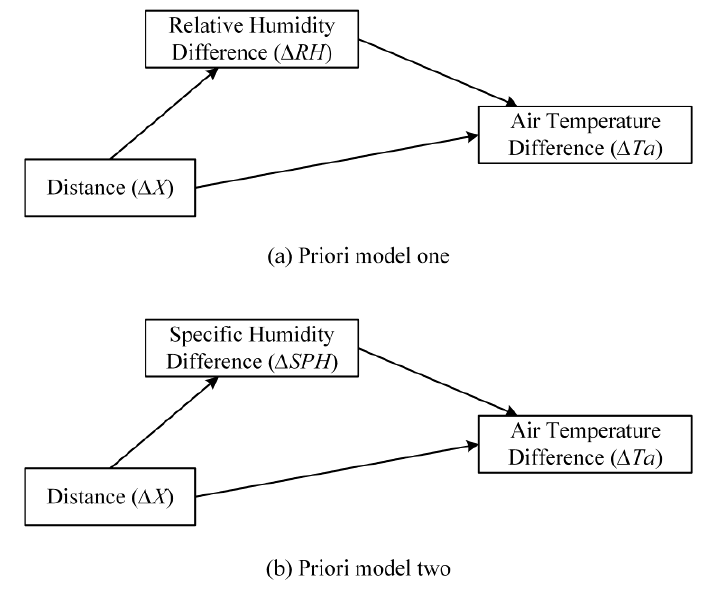
Figure 2. Two priori models for path analysis. ( a ) Priori model one; ( b ) Priori model two.